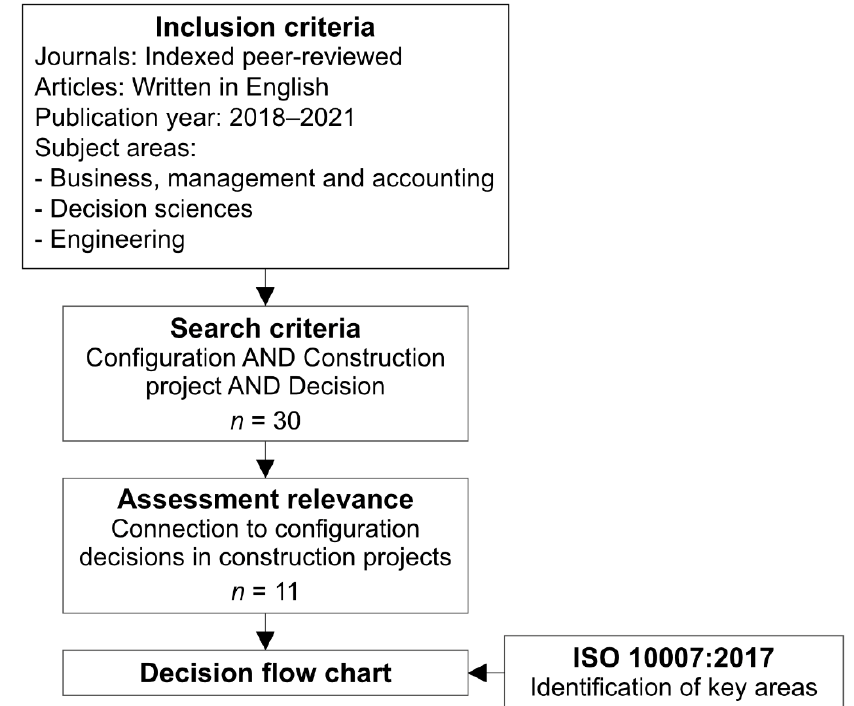
Figure 4. The method used for the literature review.